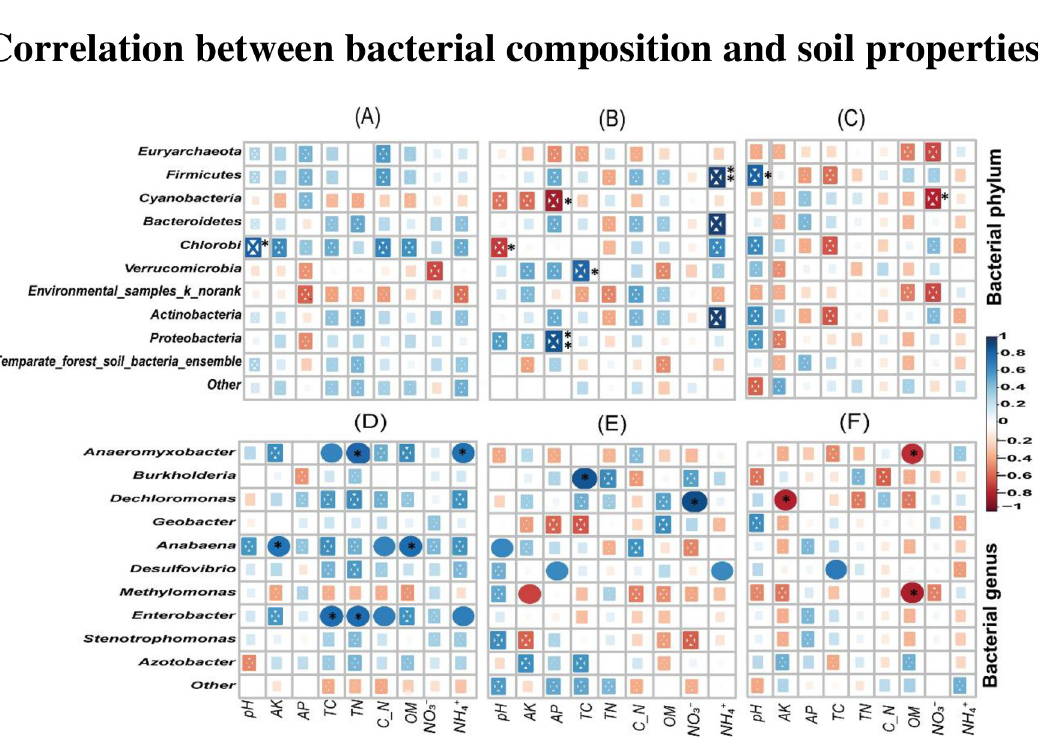
Fig 8. Pearson’s correlation coefficients for soil physio-chemical properties and the most abundant diazotrophic in different soil depth. Diazotrophic phyla in 0–20 cm (A), 20–40 cm (B) and 40–60 cm (C) and diazotrophic genera in 0–20 cm (D), 20–40 cm (E) and 40–60 cm (F) soil depths. The heatmap cells marked by “ � ” or “ �� ” are statistically significant: � p < 0.05 and �� p <